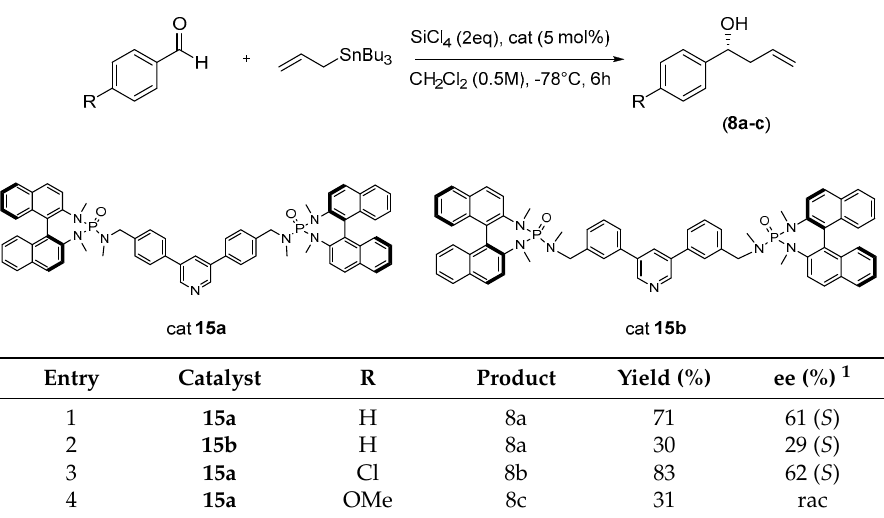
Table 2. Enantioselective allylation of aldehydes.